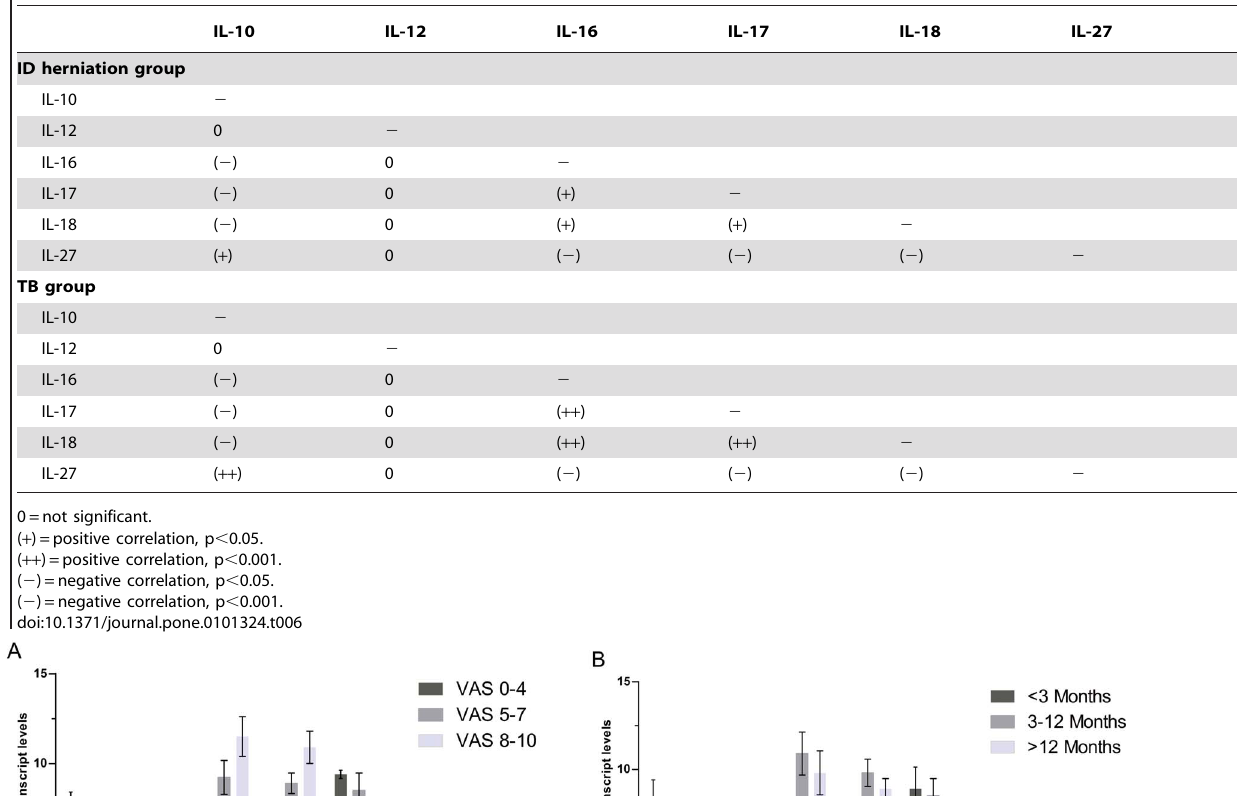
IL-10 IL-12 IL-16 IL-17 IL-18 IL-27